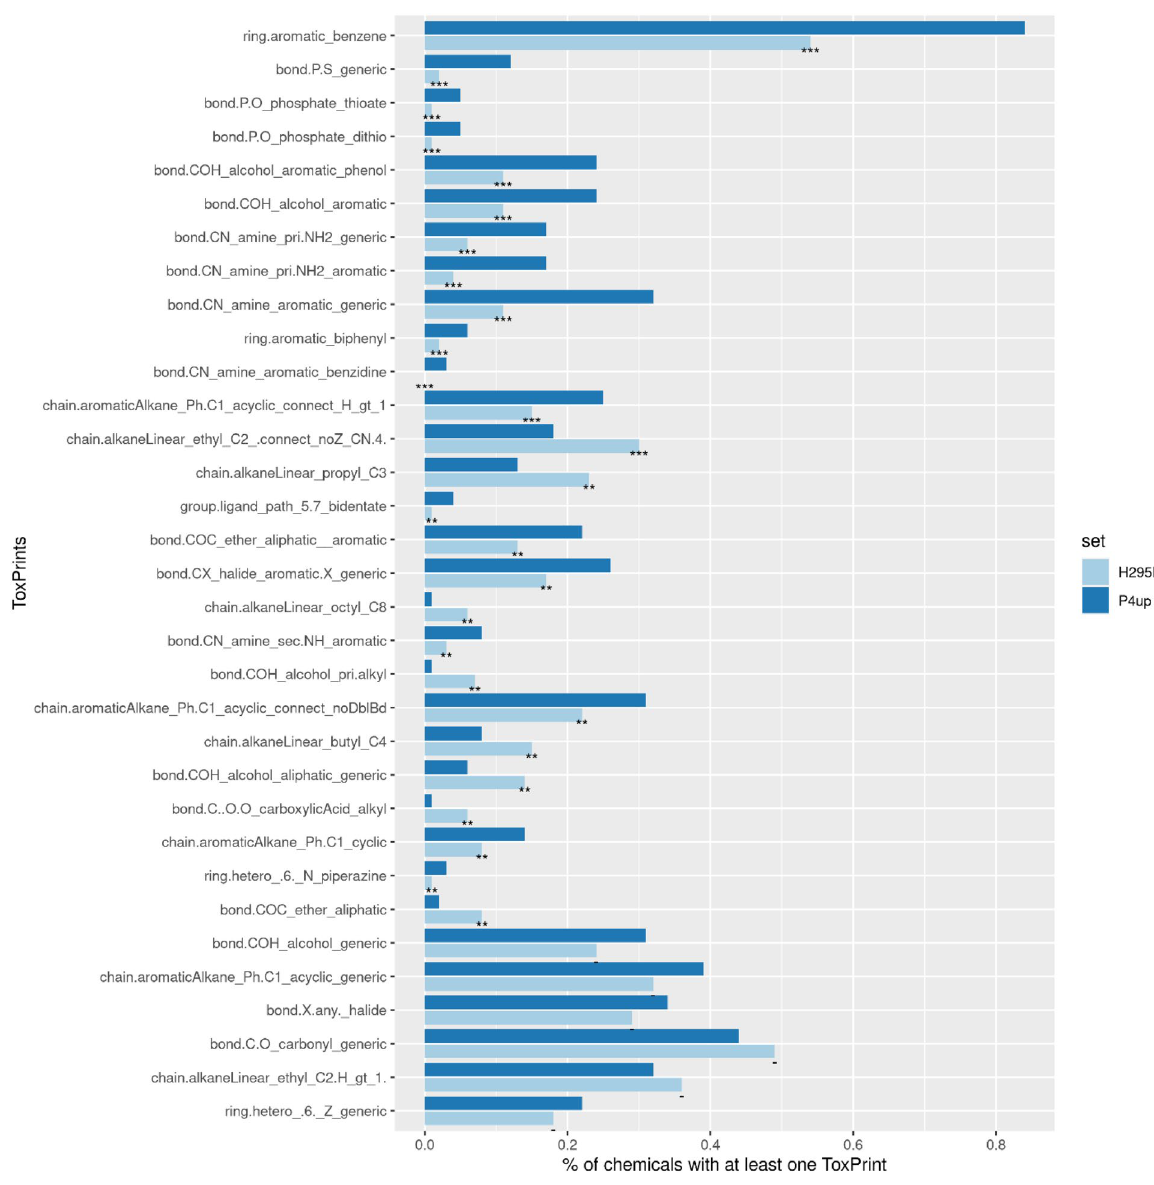
Figure 7. Distribution of ToxPrints that are significantly more common and the most represented (present in > 20% P4up chemicals) among the 729 ToxPrints identified in P4up chemicals. Statistical significance was computed using a Pearson’s chi-squared test and significant p-values are reported as: p-value < 0.001 (***), p-value < 0.01 (**), p-value < 0.05 (*) and p-value ≥ 0.05 (−). ToxPrints are ordered by p-values, from the most significant to the